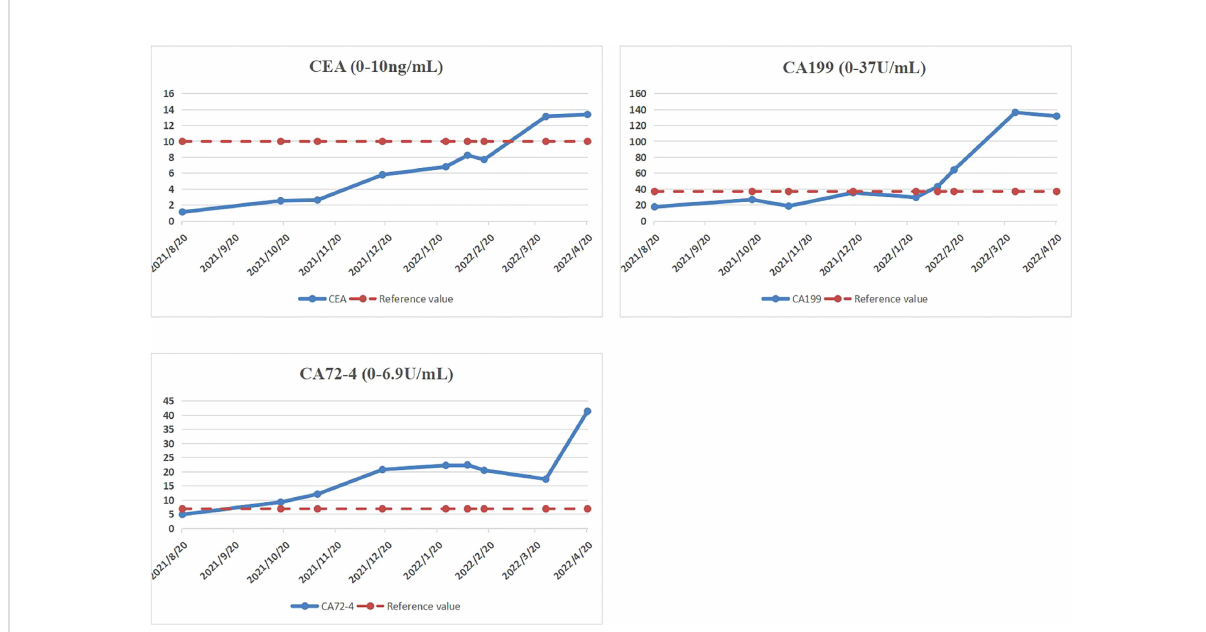
FIGURE 4 CEA, CA19-9, and CA72-4 increased gradually after radical axillary